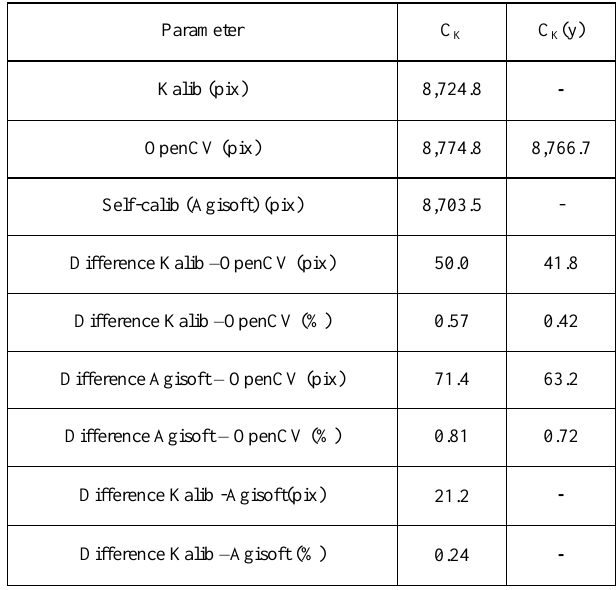
Table 3. The calibrated focal length values, differences between methods and percentage value of differences for the fixed lens.